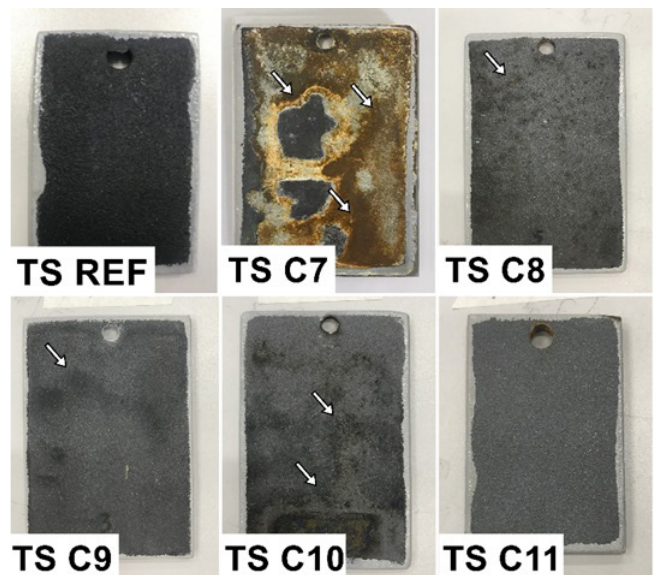
O coating by thermal spray (TS) after in-situ 2 5